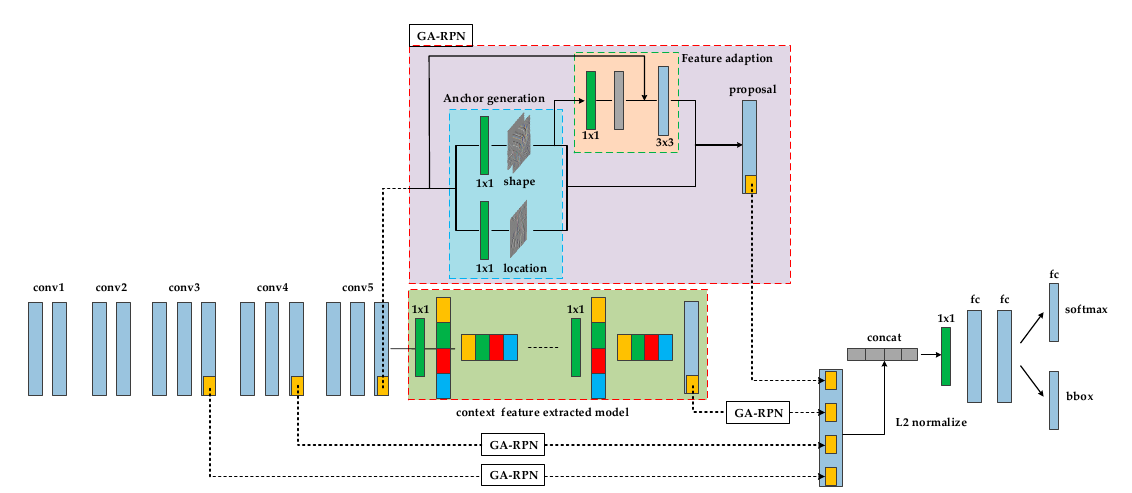
Figure 1. Structural framework of SC-Faster region-based convolutional neural network (R-CNN). The method is the Faster R-CNN framework combined with skip pooling and fusion of contextual information.